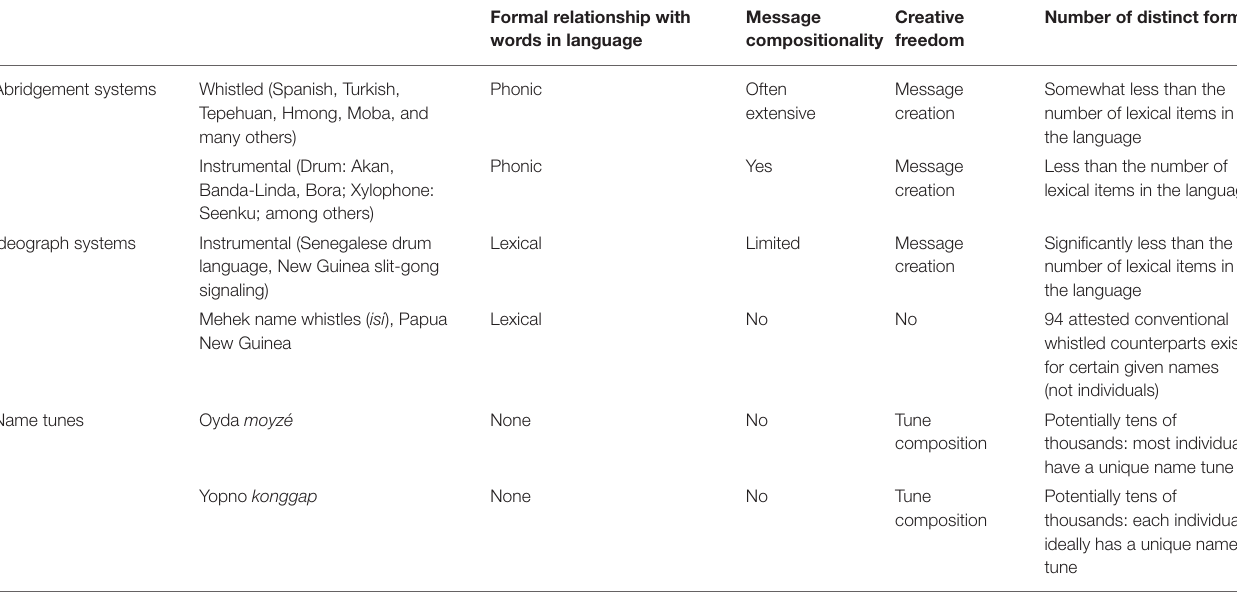
TABLE 2 | Comparison of Oyda and Yopno name tune systems with other surrogate speech